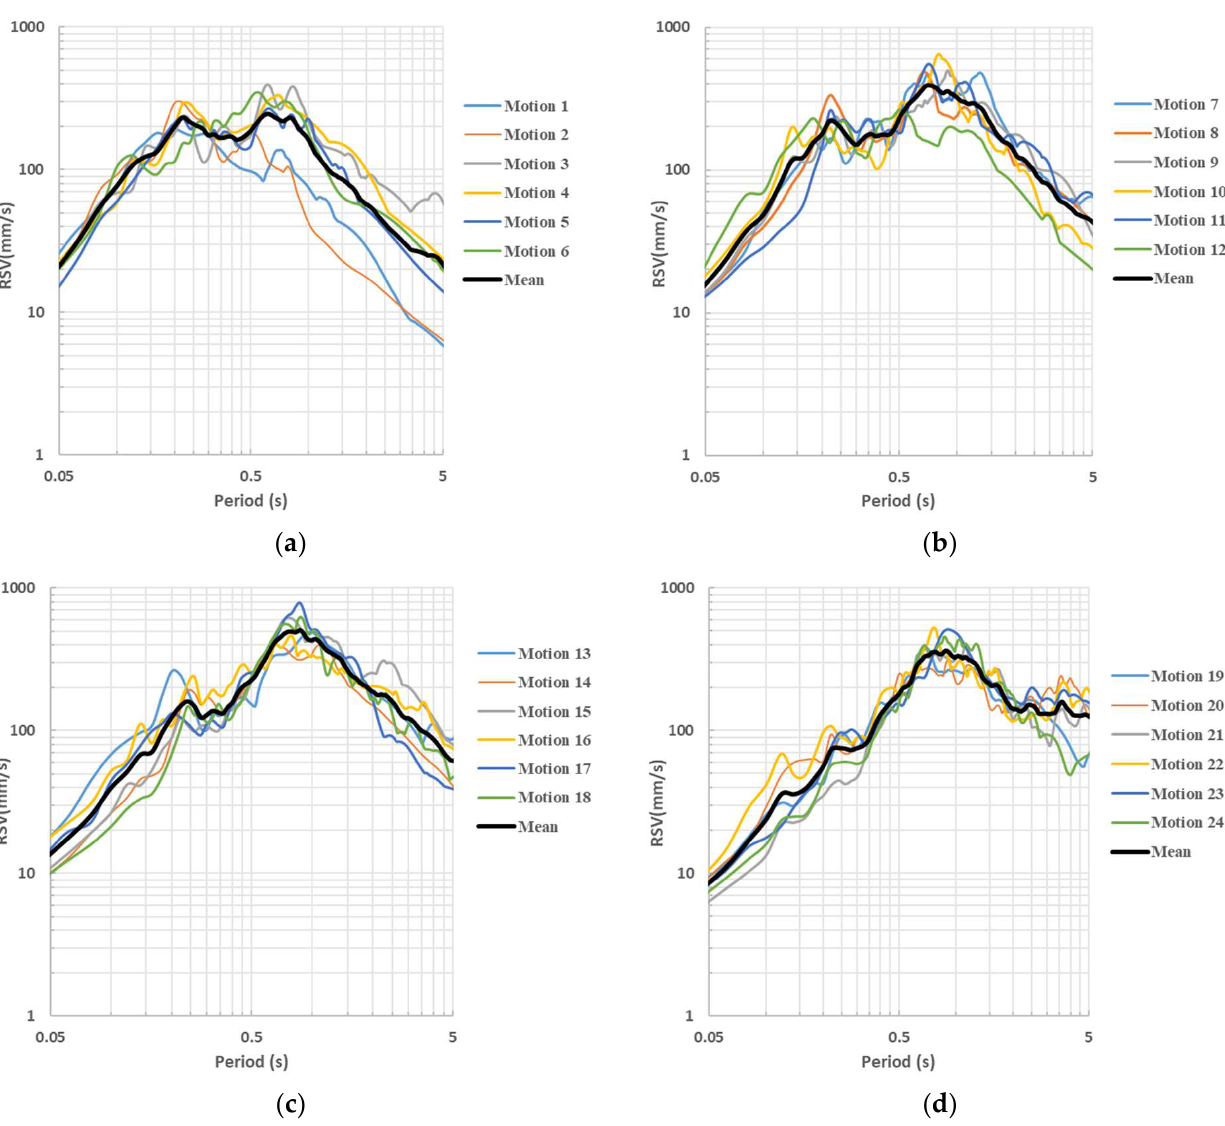
Figure 3. Individual and mean site-specific velocity response spectra for the four reference periods: ( a ) site-specific 1 (T* = 0.2 s), ( b ) site-specific 2 (T* = 0.5 s), ( c ) site-specific 3 (T* = 1 s), and ( d ) site- specific 4 (T* = 2 s).